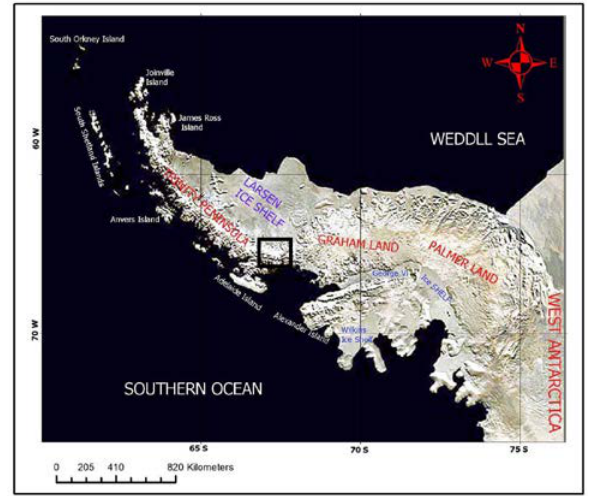
Figure 3. RGB colour combination of bands 3, 5 and 7 derived from Landsat 7 mosaic image for Antarctic Peninsula (AP). Black cube shows Landsat-8 coverage for Oscar coast area in Graham Land.